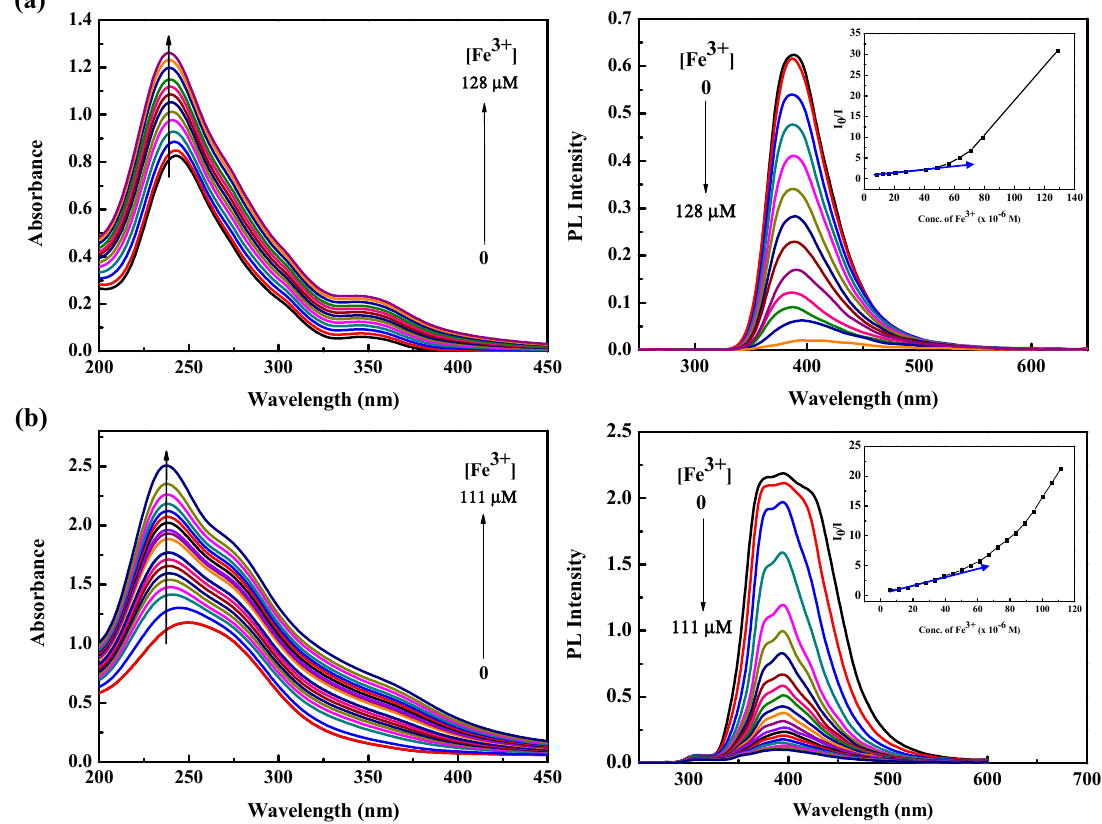
Figure 5. Absorption (left) and photoluminescence (right) spectral variations of ( a ) PCaT and ( b ) PCT in the presence of various concentrations of Fe 3+ . Concentration of polymers: 1.0 × 10 − 6 M in THF; Inset: Stern ‒ Volmer plot of fluorescence quenching with various concentrations of Fe 3+ ion.